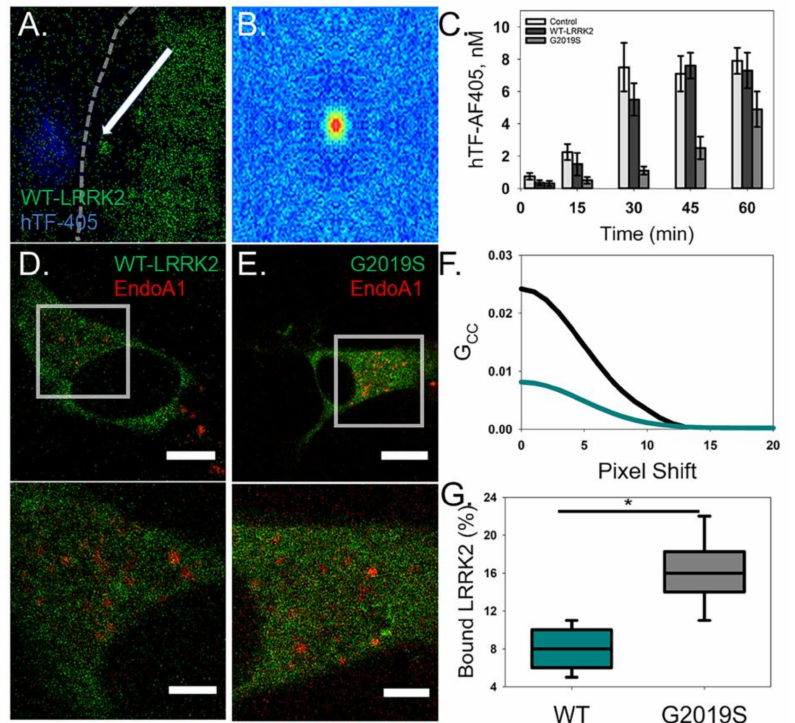
Figure 4. G2019S-expressingcellsshowareductioninendocytosisofhumantransferrin. ( A )Arepresentative image of a WT LRRK2-GFP (green)-expressing cell treated with hTF-AF405 (blue). Arrow depicts a LRRK2 boundvesiclethatmovedtoandfromthesiteofthemembrane(dashedwhiteline)withclusteredhTF-AF405. ( B ) Cross-correlation raster image correlation spectroscopy (ccRICS) autocorrelation function (ACF) of LRRK2 and hTF. ( C ) Control and transfected cells were treated with hTF-AF405 and the amount of internalized hTF-AF405 was determined, using RICS, at the designated time points. Error is shown as the S.E.M. ( D , E ) Representative intensity images of cells co-expressing EndoA1-mCherry (red) with either WT LRRK2-GFP (left; green) or G2019S LRRK2-GFP (right; green). Scale bar is 15 µ m. ROI selected for ccRICS analysis corresponding to the boxed regions within the full cell intensity images. Scale bar is 3 µ m. ( F ) Representative fits of the ccRICS ACF for WT (dark cyan) and G2019S (black) with EndoA1-mCherry. ( G ) The amount of LRRK2 interacting with EndoA1-mCherry as a percentage of total protein ( p <